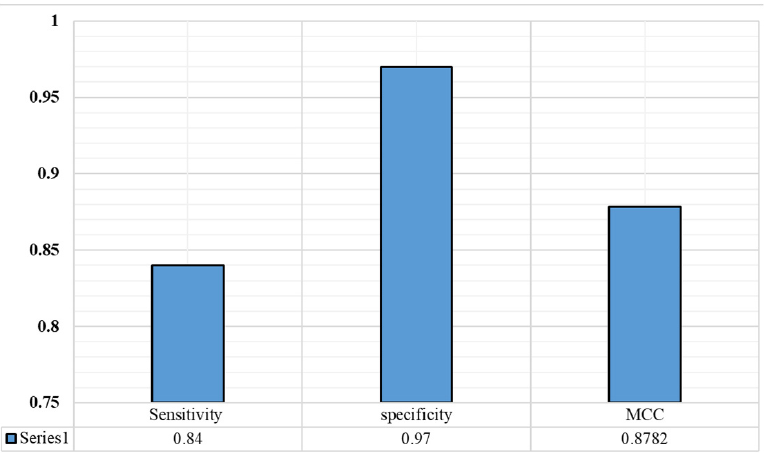
Figure 6. The proposed model’s sensitivity, specificity, and Matthews correlation coefficient.